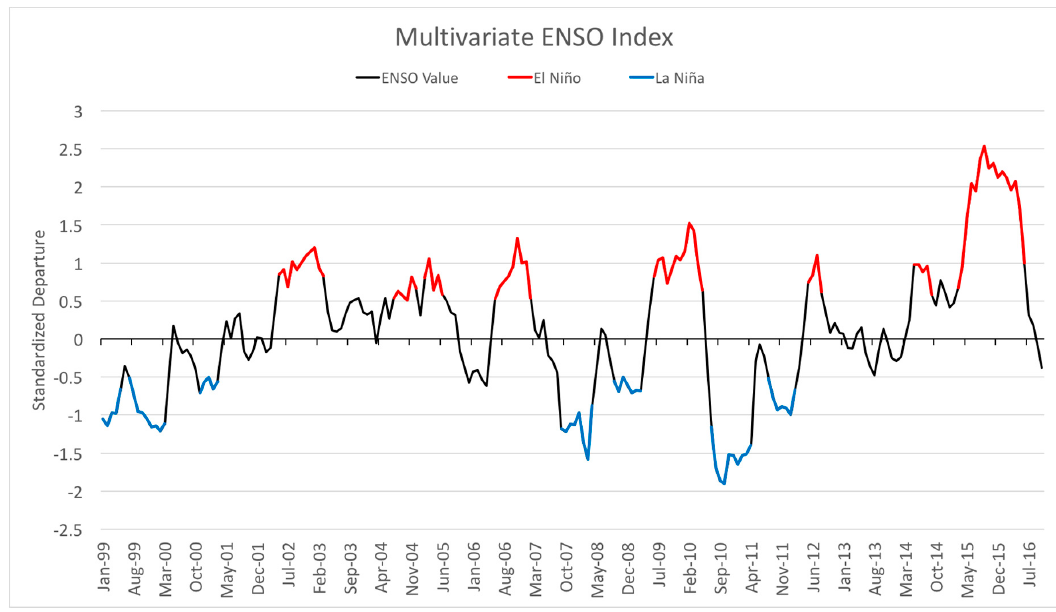
Figure 2. The standardized departure of the Multivariate El Niño Southern Oscillation (ENSO) Index values between 1999 and 2016 [26]. The red values indicate months with El Niño conditions, and the blue values indicate months with La Niña conditions.